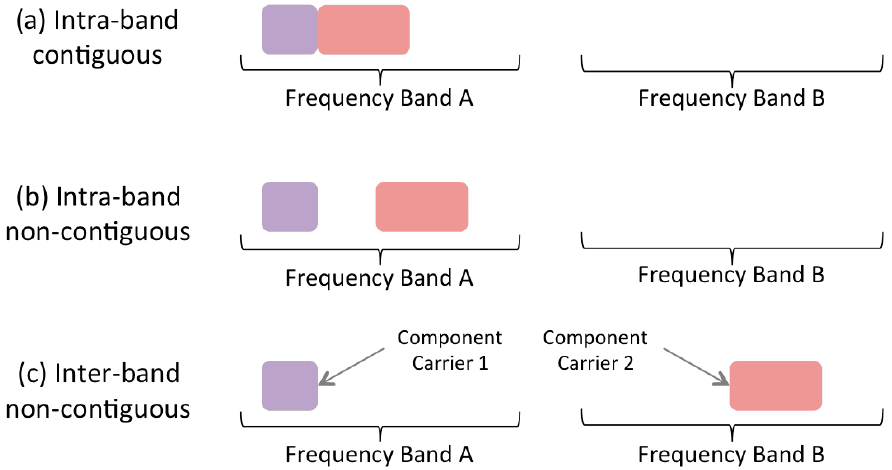
Figure 2. Carrier Aggregation types.